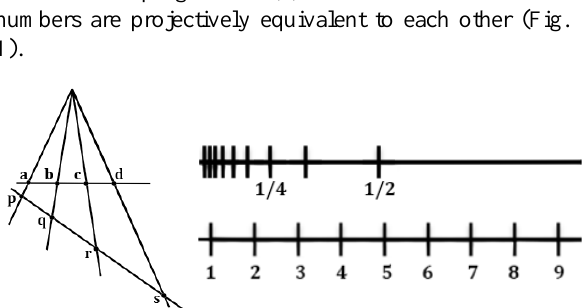
Fig. 1 . Examples of projective transformation. Left: a central projective transformation changes the lengths of the line segments and their simple ratios, but retains the magnitude of the cross-ratio. Right: the location of the numbers of the harmonic progression (1) and a series of natural numbers on the number